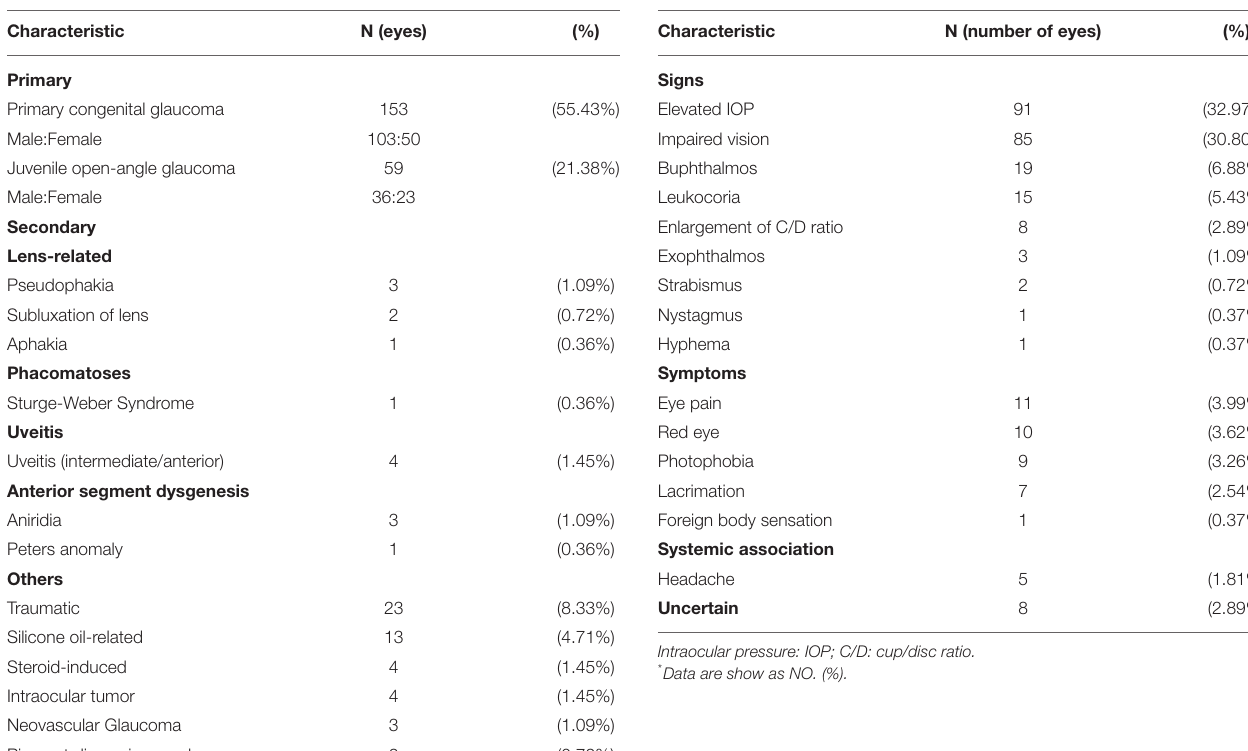
TABLE 2 | Diagnostic findings in patients with surgical pediatric glaucoma * . TABLE 3 | Different main symptoms and signs of the pediatric glaucoma patients * .